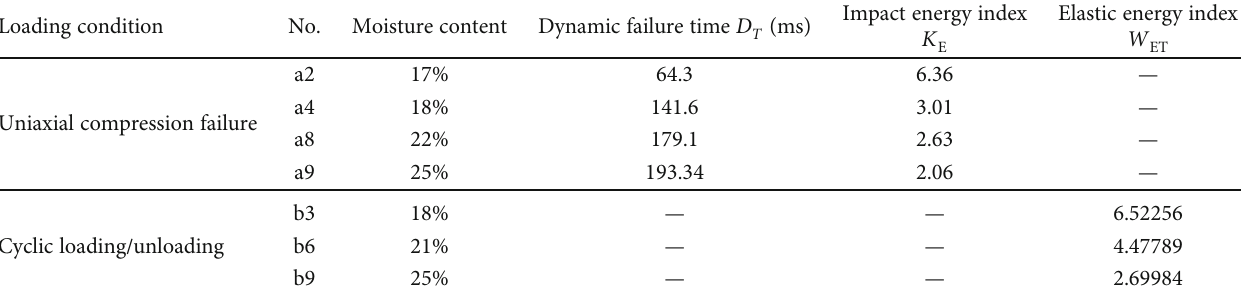
Table 5: Test values of burst tendency of some coal